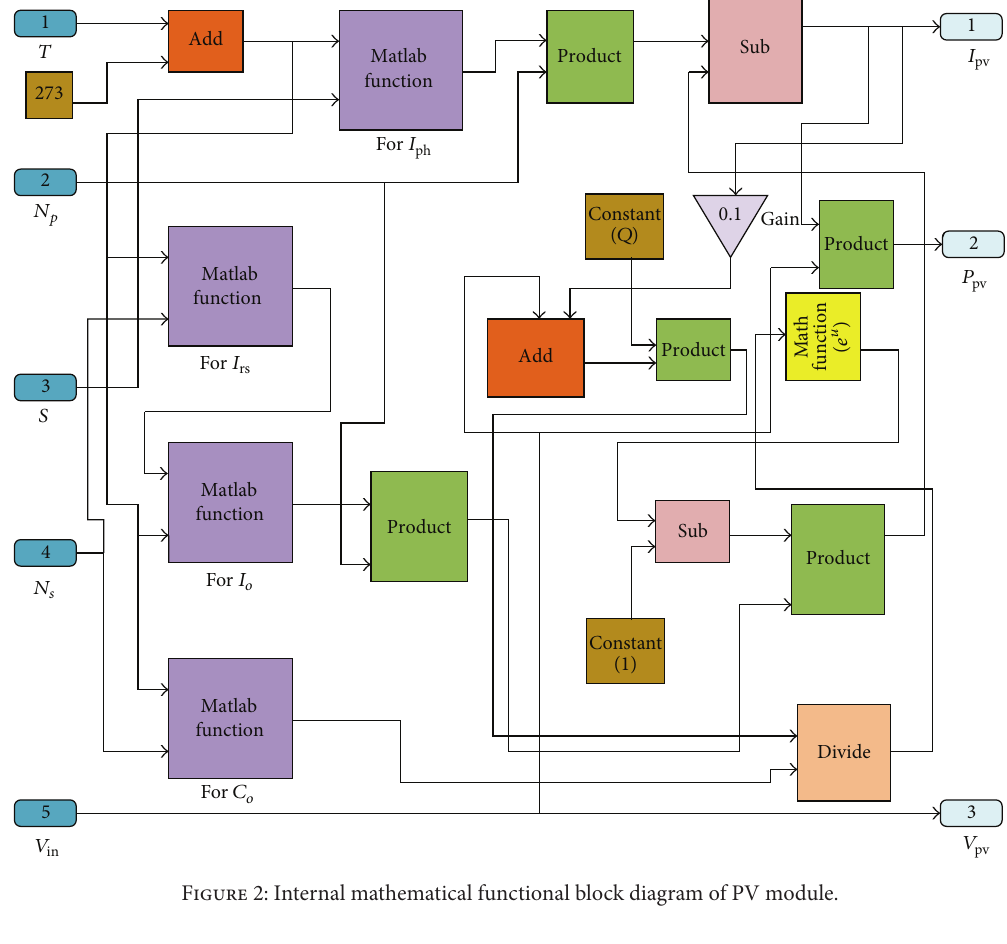
Figure 2: Internal mathematical functional block diagram of PV module.